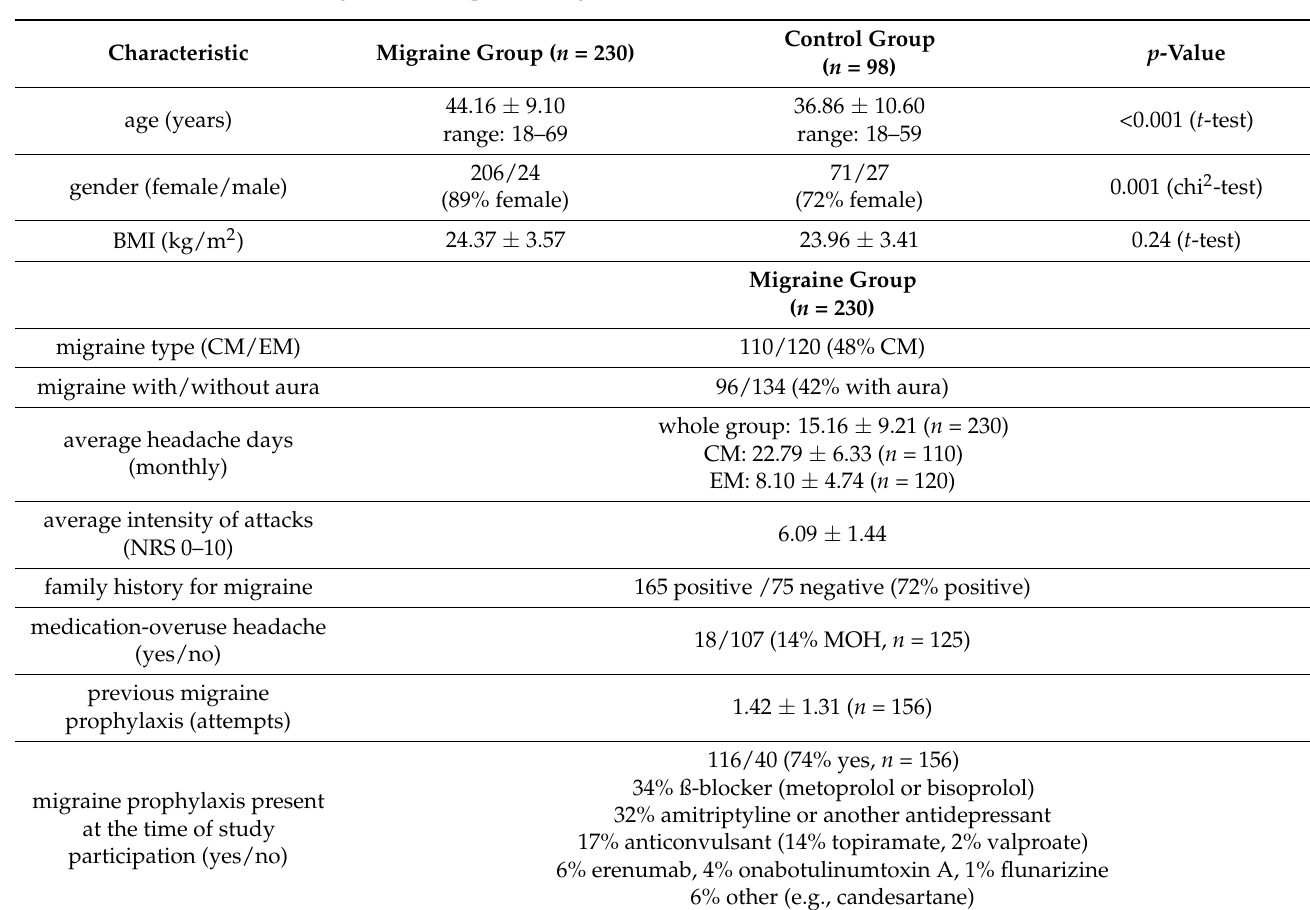
Table 1. Demographic and headache-related parameters of the study groups. Unless otherwise stated, values are presented as mean ± standard deviation (SD). Regarding demographic parameters, migraine and control groups were compared using the tests indicated in the table. Monthly headache days were averaged using headache diaries in the last three months before study inclusion. This was also carried out for the attack intensities. When migraine with aura was diagnosed, attacks without aura could also occur in the same patient. For migraine prophylaxis, only data on medication-based regimens were evaluated. CM: Chronic migraine; EM: Episodic migraine; MOH: Medication-overuse